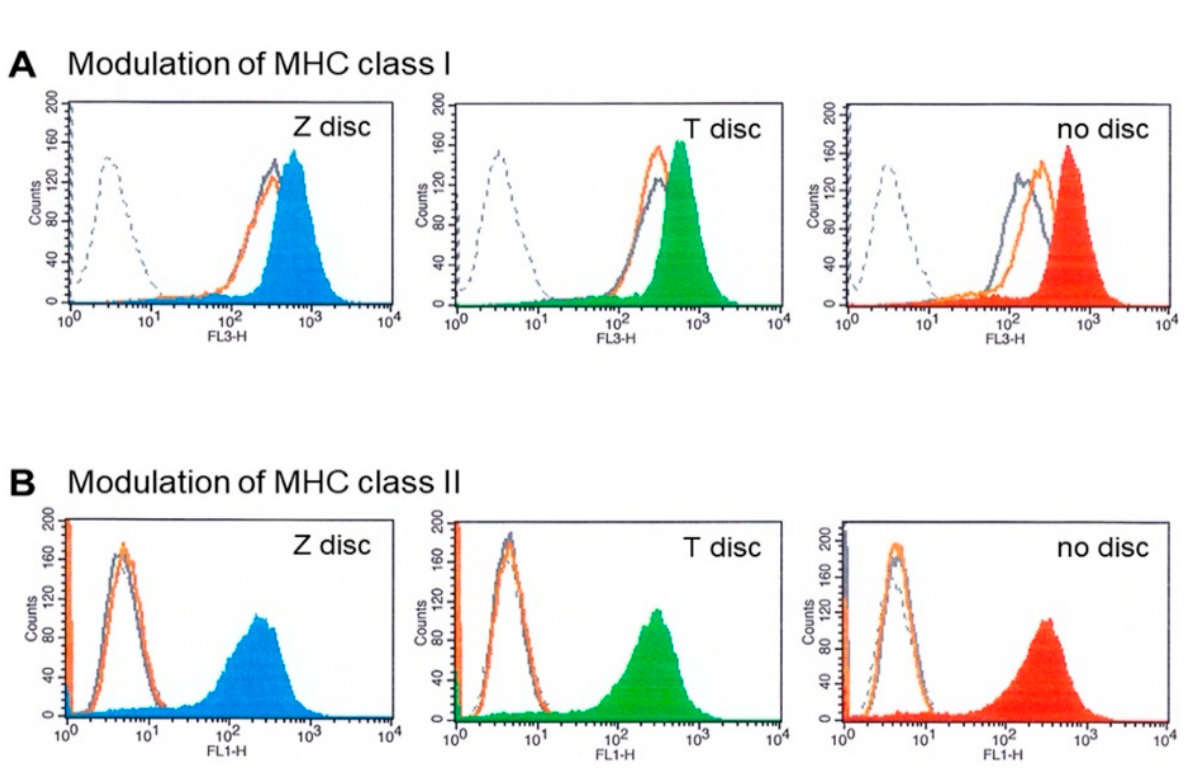
Figure 4. ( A ) MHC class I modulation. Flow cytometry analysis of MG-63 cells cultivated for 72 h on T or Z discs and then stimulated with IFN- α or IFN- γ for 48 h. The MG-63 cells express high amounts of MHC class I (grey histograms), after stimulation with IFN- γ the overexpression of MHC class I was observed in the MG-63 cells (on Z disc—blue histogram; on T discs—green; in a sample without discs—red histogram). Stimulation with IFN- α did not change the MHC class I expression (orange histograms). The black dotted histograms represent isotype-matched negative controls. ( B ) MHC class II modulation. Flow cytometry analysis of MG-63 cells cultivated for 72 h on Z or T discs and then stimulated with IFN- α and IFN- γ for 48 h. The expression of MHC class II was analyzed. After stimulation with IFN- γ the MG-63 cells overexpressed MHC class II proteins (on Z disc—blue histogram; on T discs—green; without discs—red histogram). Stimulation with IFN- α did not influence the MHC class II expression (orange histograms), which overlap with the histograms of unstimulated cells (grey histograms) and with histograms of isotype control (black dotted histograms).